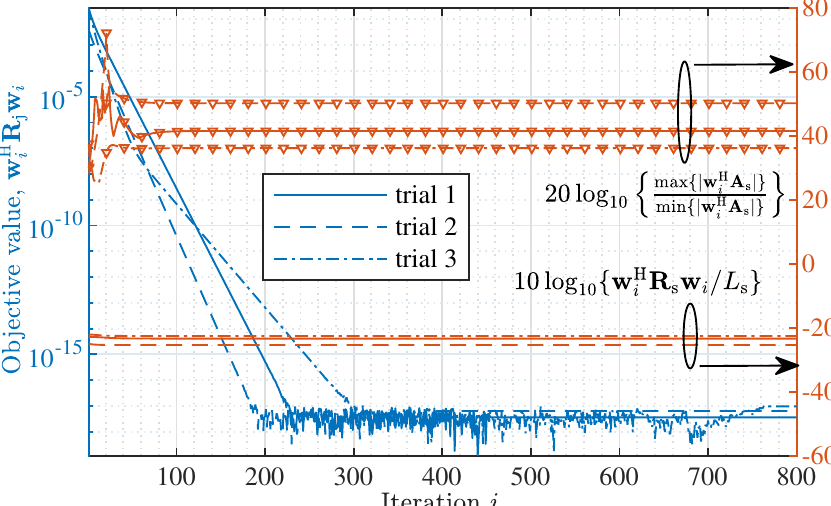
Figure 2. Left : The value of the objective function given in (8) under the iterative solution given in (14), where N = 16, δ θ = 0.1 ◦ , Θ j = { 30.5 ◦ ,60.9 ◦ , − 50.3 ◦ } and I = 800 is the total number of iterations. Right : Features of the obtained beam in the spatial passband. Three trials are performed with w 0 randomly and independently generated for each